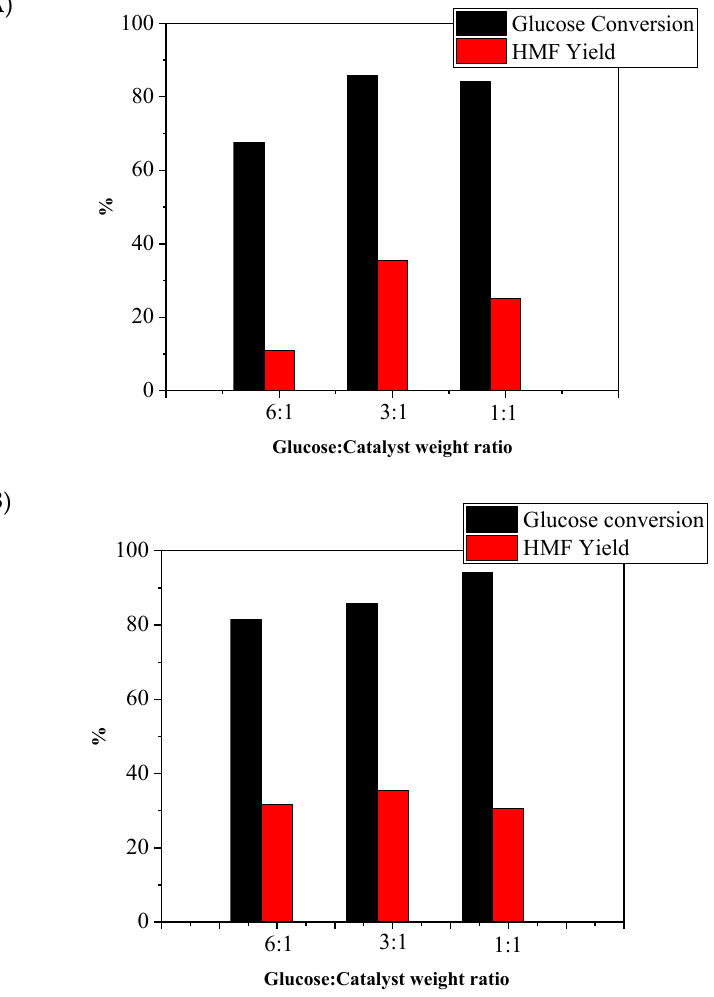
Figure 9. Influence of glucose:Al 7 Zr 3 weight ratio, by modifying the amount of glucose ( A ) or catalyst ( B ), on the catalytic performance (150 ◦ C, 60 min and 0.65 g CaCl2 · g aq.sol. − 1 ( B ), on the catalytic performance (150 °C, 60 min and 0.65 g CaCl2 ·g aq.sol. − 1 ).